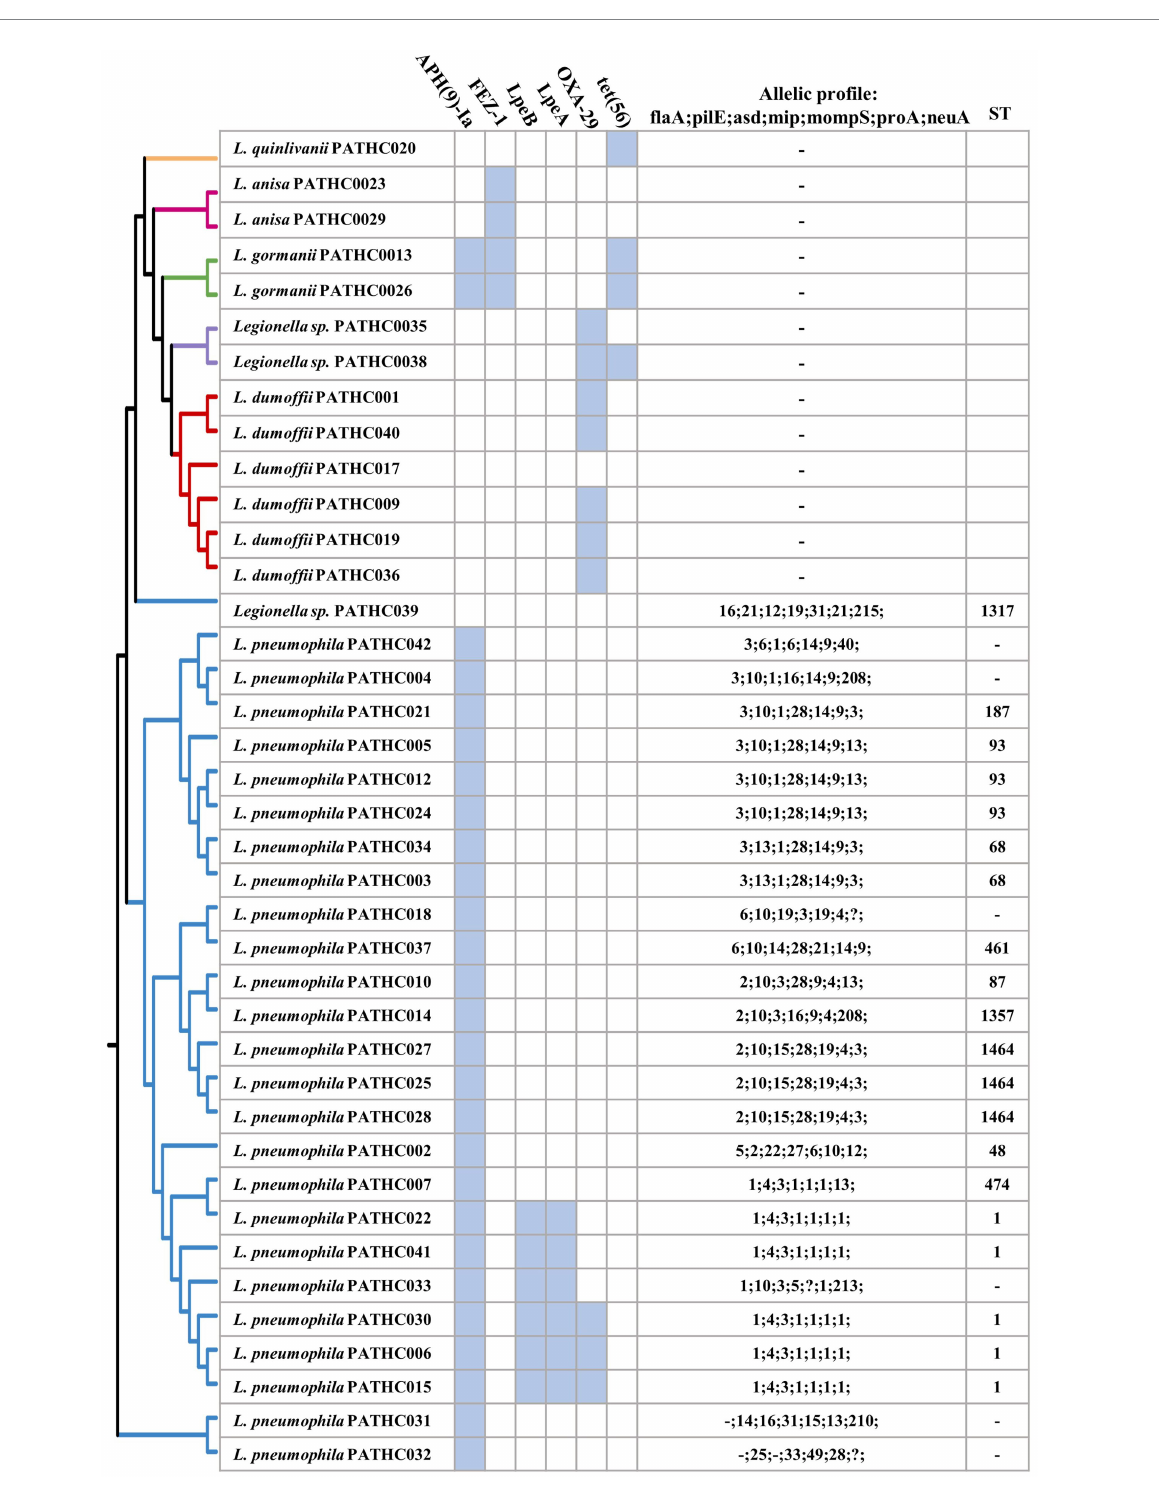
mutations in proteins encoded by genes gryA, gryB, parC, rpoB, rplD, and rplV (Nielsen et al., 2000; Jonas et al., 2003; Almahmoud et al., 2009; Descours et al., 2017). However, the named